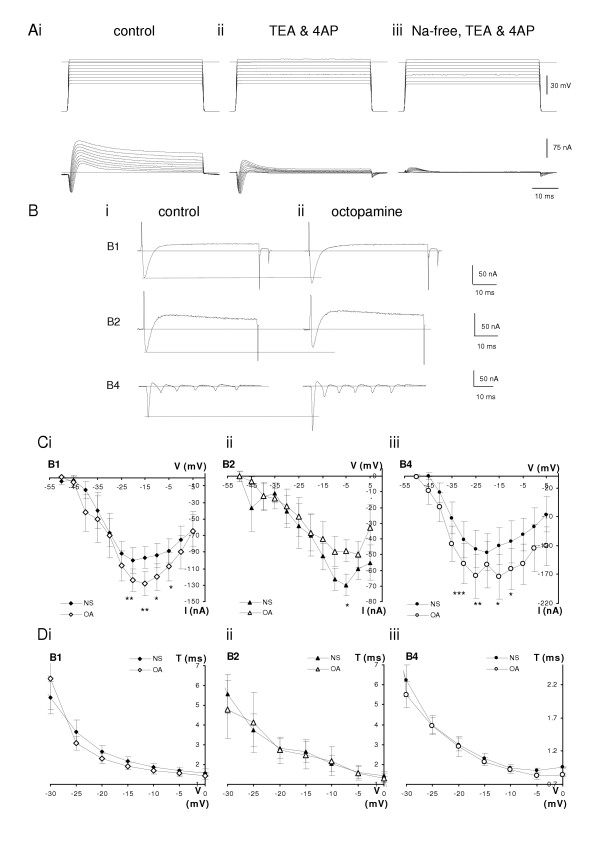
Analysis of the inward currents of buccal neurons. Ai. A series of voltage-steps from a holding potential of -80 mV to between -35 mV and +5 mV on B1 motoneuron. In normal saline an initial fast inward current is followed by outward current. Aii. In saline containing 50 mM tetraethylammonium (TEA) and 4 mM 4-aminopyridine (4-AP) the inward current component is slightly increased while both (the transient and delayed) outward current strongly inhibited. Aiii Changing to Na free saline with the same TEA and 4-AP concentrations shows only a small transient outward current while the inward current is blocked completely. B. Addition of octopamine to normal saline enhances the amplitude of the fast inward currents in B1 and B4 neurons but not in the B2 motoneuron. Individual current traces of representative experiments from -50 mV stepped to -20 mV, -10 mV and -20 mV, respectively in normal saline. The fast inward current is followed by a slower outward component (Bi). In the presence of 10 μM octopamine the fast inward components are increased on B1 and B4 neurons without substantial changes of the outward currents, while the inward current on B2 neuron is decreased (Bii). C. I-V characteristics of the voltage-evoked fast inward currents show increased peak values of the B1 (Ci, n = 8) and B4 (Ciii, n = 8) neurons in the presence of 10 μM octopamine. B2 neurons (n = 6) show decreased amplitudes of the fast inward current (Cii). D. The time at which the peak inward current was observed is not affected by 10 μM octopamine in the B1, B2 or B4 neurons (same preparations as C). In B, C and D experiments were done in normal saline (NS filled symbols) or normal saline supplemented with 10 μM octopamine (OA empty symbols). Mean ± SE. Asterisks mark significance levels of 5% (*), 1%(**) and 0.1% (***).